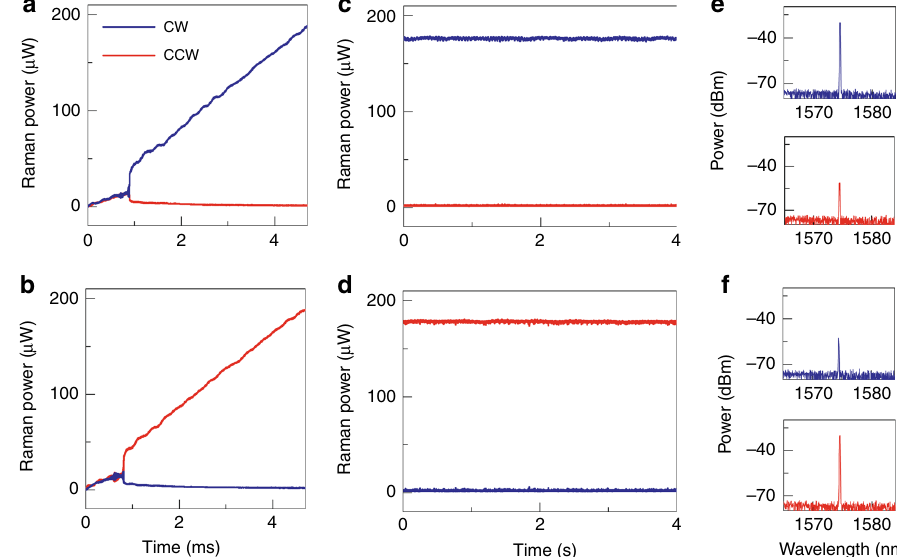
Fig. 3 Stable Raman lasers with high chirality. a , b Similar to Fig. 2c, d but with a different pump mode, exhibiting higher chirality and lower threshold power. c , d The chiral Raman laser emits stably at stationary states when the pump laser is self-locked in the mode, resulting in a fi xed intracavity pump light power. e , f The optical spectra of the Raman laser emitted in CW and CCW directions, where the resolution of the spectrometer in measurement is 0.04 nm.